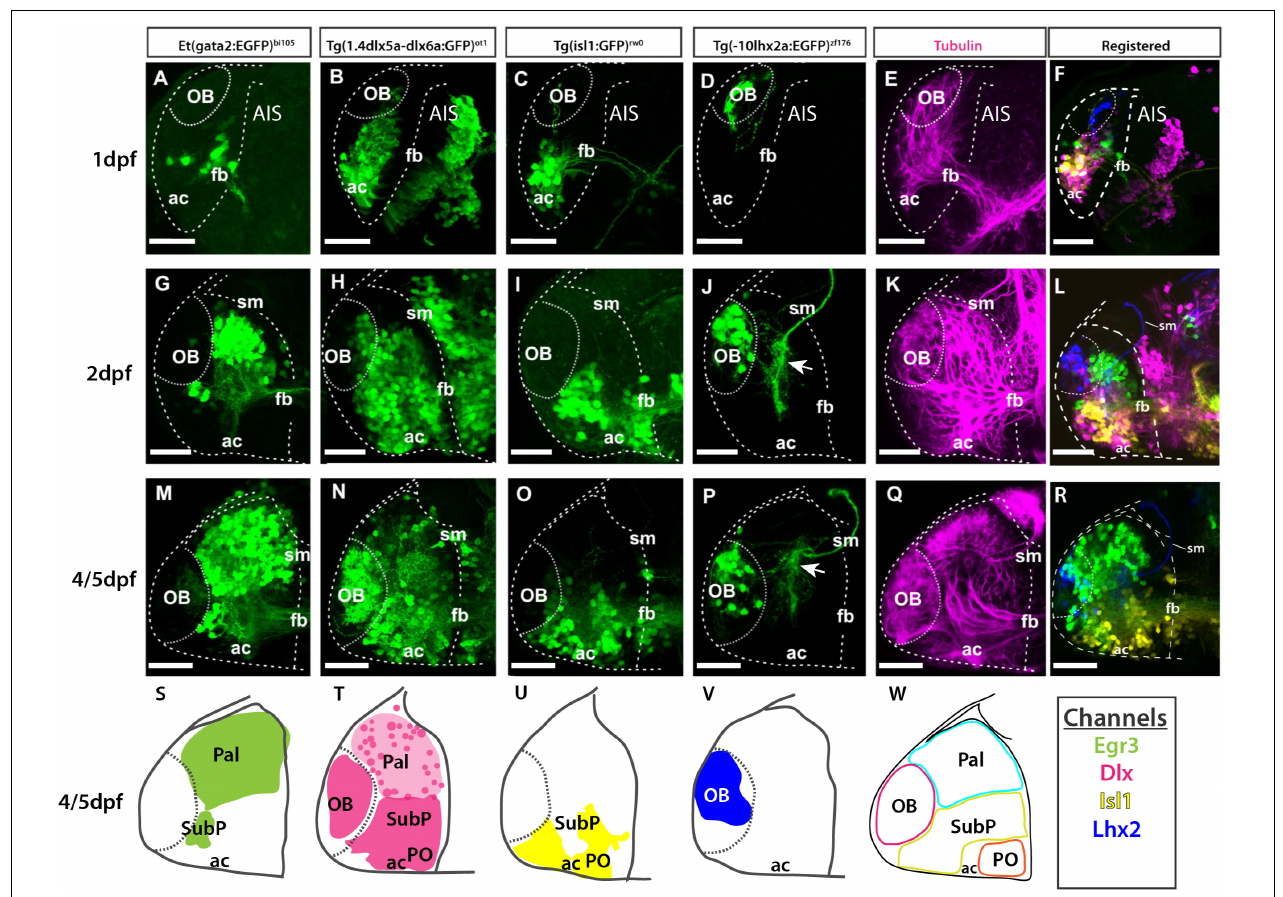
FIGURE 9 | Atlas of transgene expression in the developing telencephalon: Lateral views. Et (gata2:EGFP) bi105 in comparison with Tg( 1.4dlx5a-dlx6a :GFP) ot1 , Tg( isl1 :GFP) rw0 , Tg(- 10lhx2a:EGFP ) zf176 and acetylated tubulin antibody staining. Lateral views of 1dpf, 2dpf and 4/5dpf fish stained against GFP (A–D,G–J,M–P) and acetylated tubulin (E,K,Q). Images are projections of confocal stacks. Rostral to the left. (N) 4dpf; (M,O–R) 5dpf. (S–W) Schematics showing the location of the GFP+ cells in the different transgenic lines. (W) Schematic showing all GFP+ domains. (F,L,R) Transgenic datasets registered to a single reference brain for each developmental stage, with the exception of 4dpf Tg( 1.4dlx5a-dlx6a :GFP) ot1 which could not be registered to 5dpf data. Channels key below final column shows the color of each transgenic in the registered images and the schematics. Scale bars: 50 µ